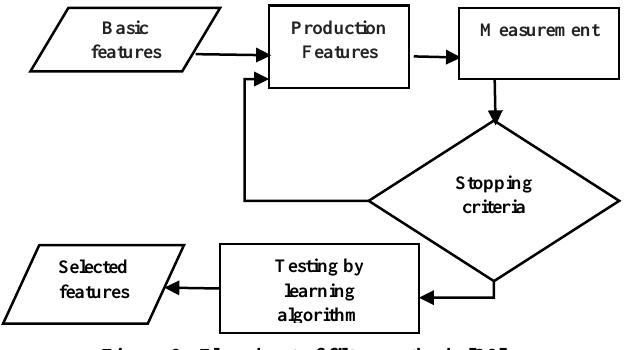
Figure 2 . Flowchart of filter methods [36].